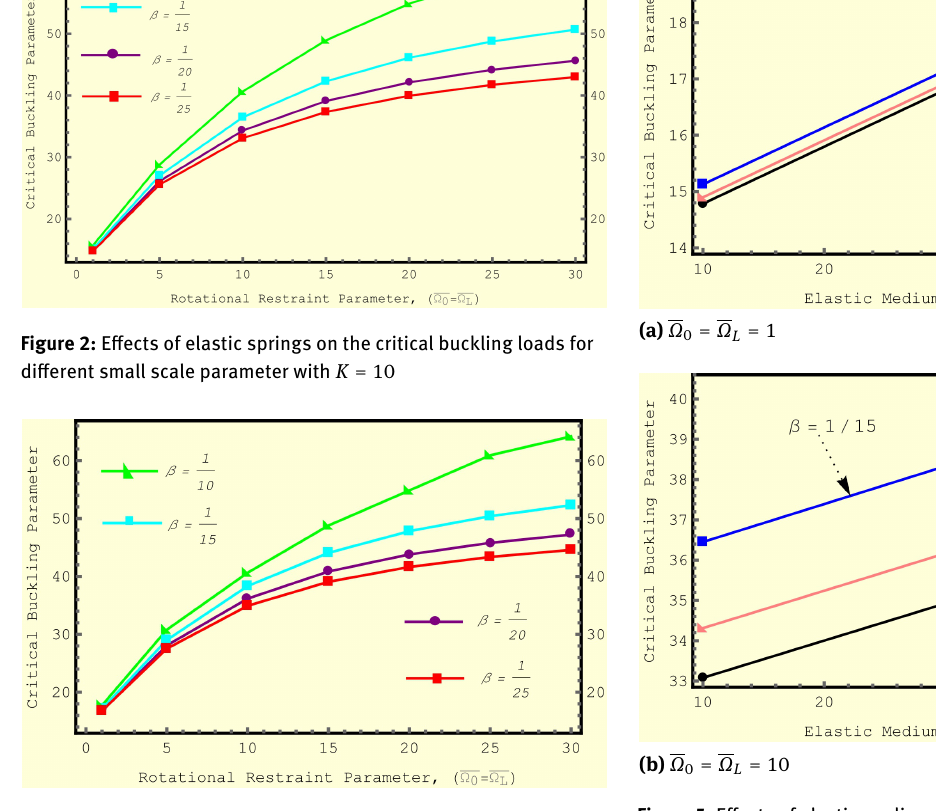
Figure 5: Effects of elastic medium parameter on the buckling loads for different small scale